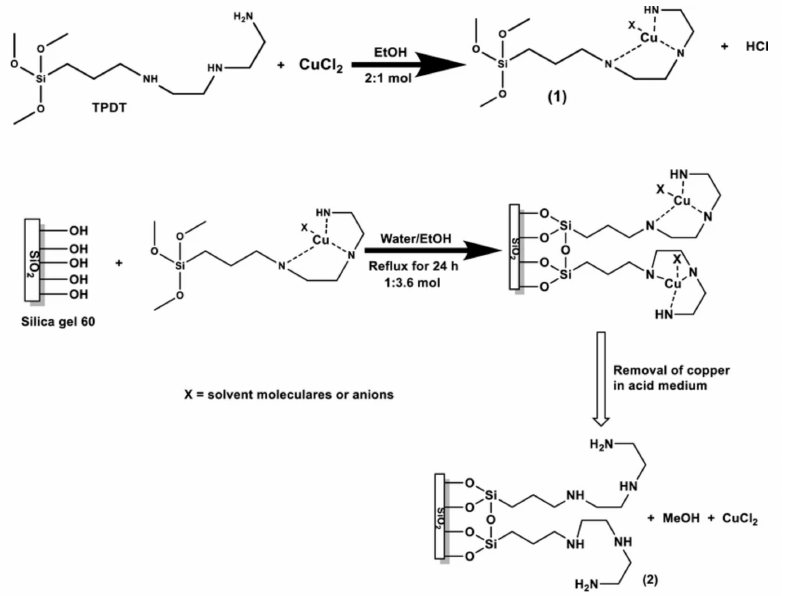
Figure 17. Synthesis of copper imprinted TPDT-functionalized silica. Reproduced with permission of Elsevier from